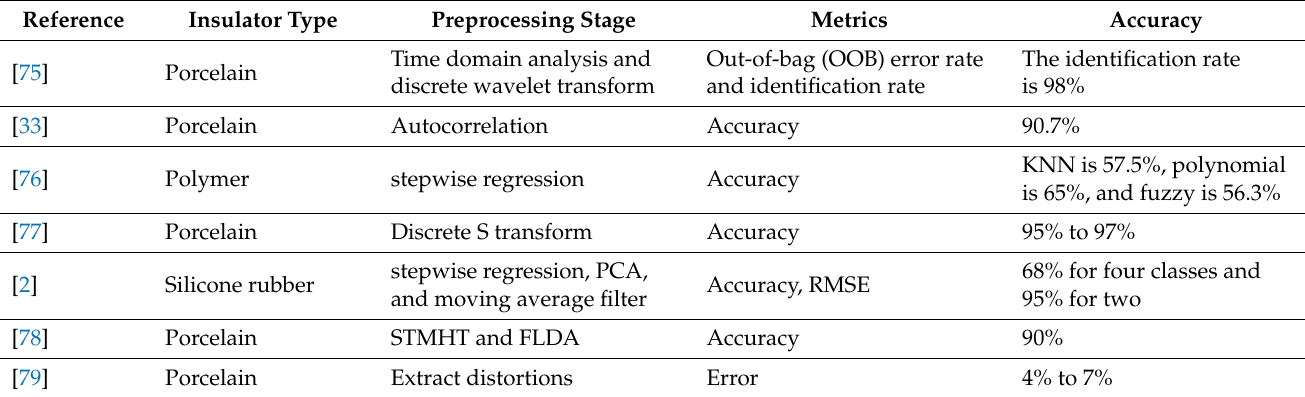
Table 6. The comparison between different signal processing techniques for leakage current in terms of